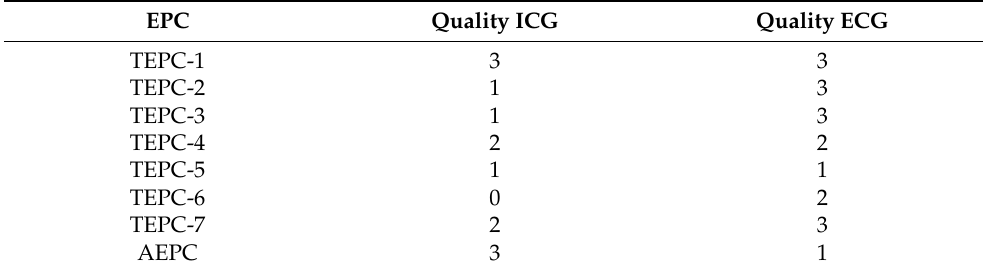
Table 3. Quality estimation comparison of the signals of ICG (0, 1—not acceptable; 2, 3— acceptable [12]) and ECG (1—conditionally acceptable; 2, 3—acceptable) for the same